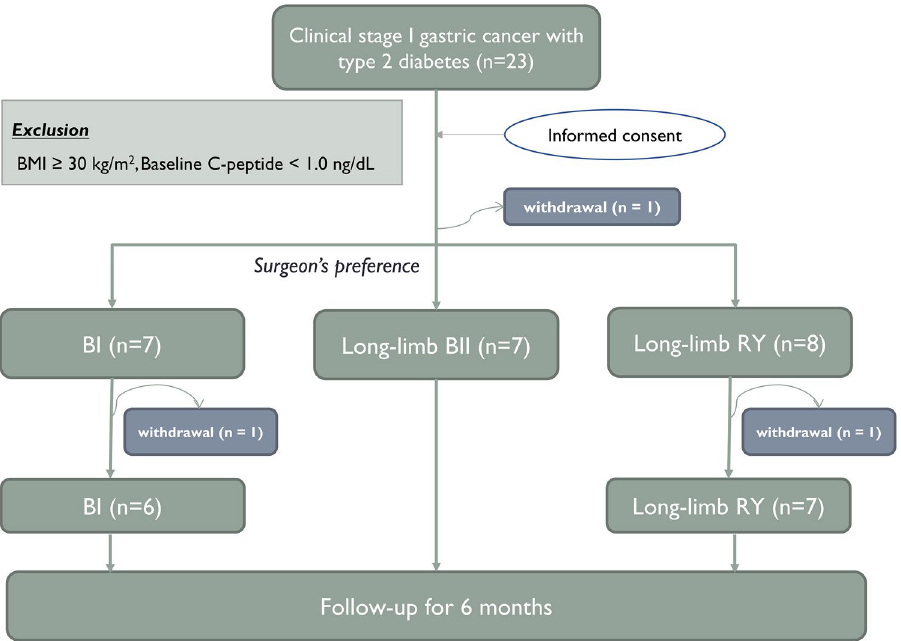
Figure 2. Flow diagram of the study progress ( BMI body mass index, BI Billroth I, BII Billroth II, RY Roux- en-Y).